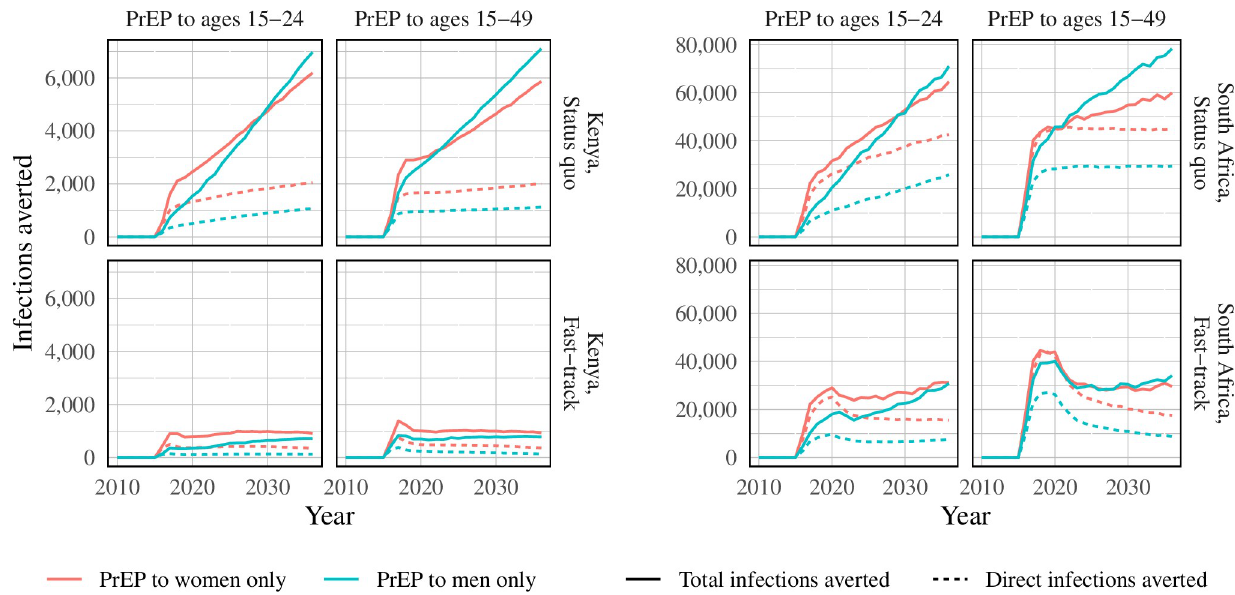
Fig 1. Direct prevention and total averted infections compared to status quo and fast-track baseline scenarios in South Africa and a status quo baseline scenario in Kenya.